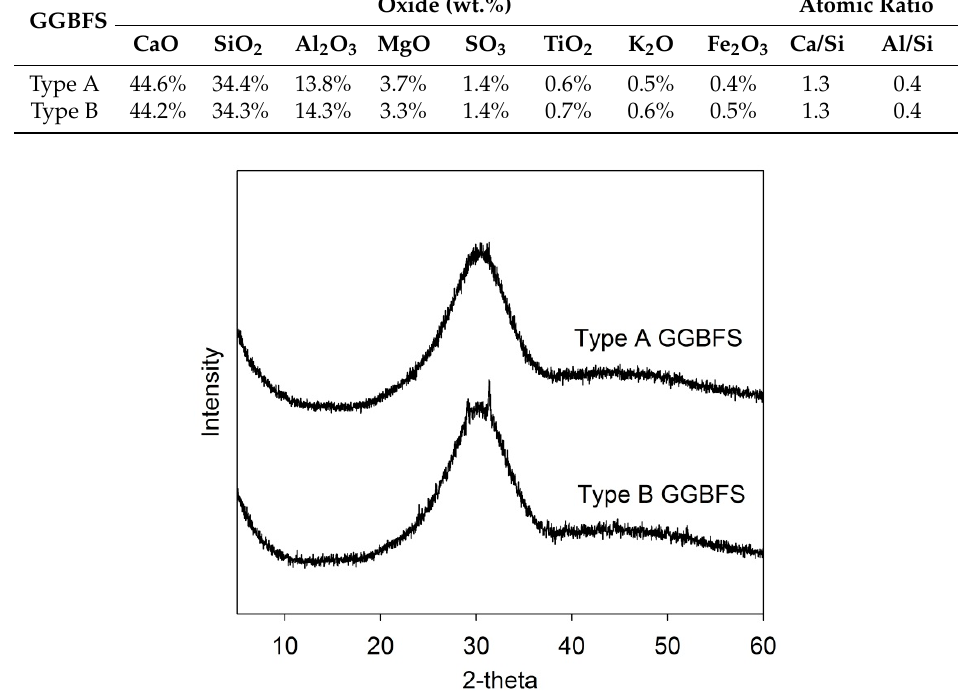
Figure 1. Powder XRD (X ‐ ray diffraction) of the raw GGBFSs (ground granulated blast ‐ furnace slags): the weak crystalline peak in the type B GGBFS is akermanite.